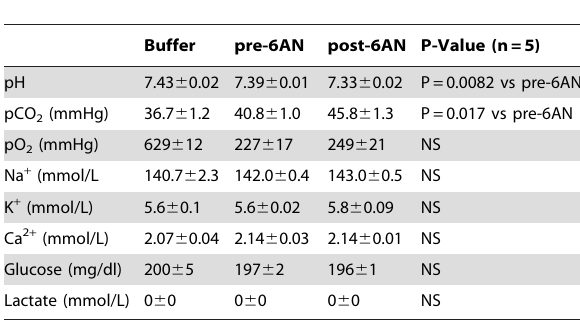
Figure 3. Inhibitory effects of 6AN on I Ca-L in isolated rat cardiomyocytes and effect of NADPH on 6AN-induced inhibition of I Ca-L . A and B: I Ca-L were evoked by 500-ms depolarizing pulses to 10 mV applied every 30 s from a holding potential of 2 80 mV. Cells were superfused with 6AN (5 mM) for 10 minutes after the currents had stabilized. Both the raw traces (A) and I–V relationships (B) show that I Ca-L amplitudes were significantly reduced by 6AN. Currents were normalized to the peak amplitude at 0 mV in the absence of 6AN. Summary data for the normalized current densities (C) and time-course (D) indicate inhibition of I Ca-L by 6AN. Stead-state activation (E) and inactivation (F) curves suggest 6AN had no significant effect on activation and inactivation kinetics. Summary data for the normalized current densities in cells dialyzed with NADPH (100 m M) and exposed to 6AN are shown. The I–V relationships indicate that I Ca-L amplitudes were significantly reduced by 6AN (G), but that dialysis of NADPH partially reversed their inhibitory effect. In contrast NADH had no effect on 6AN-induced inhibition of I Ca-L (H). Currents were normalized to the peak amplitude at 0 mV in the absence of 6AN. *P , 0.05 vs. control. # P , 0.05 vs 6AN. doi:10.1371/journal.pone.0045365.g003 Table 1. Blood gas analysis of coronary